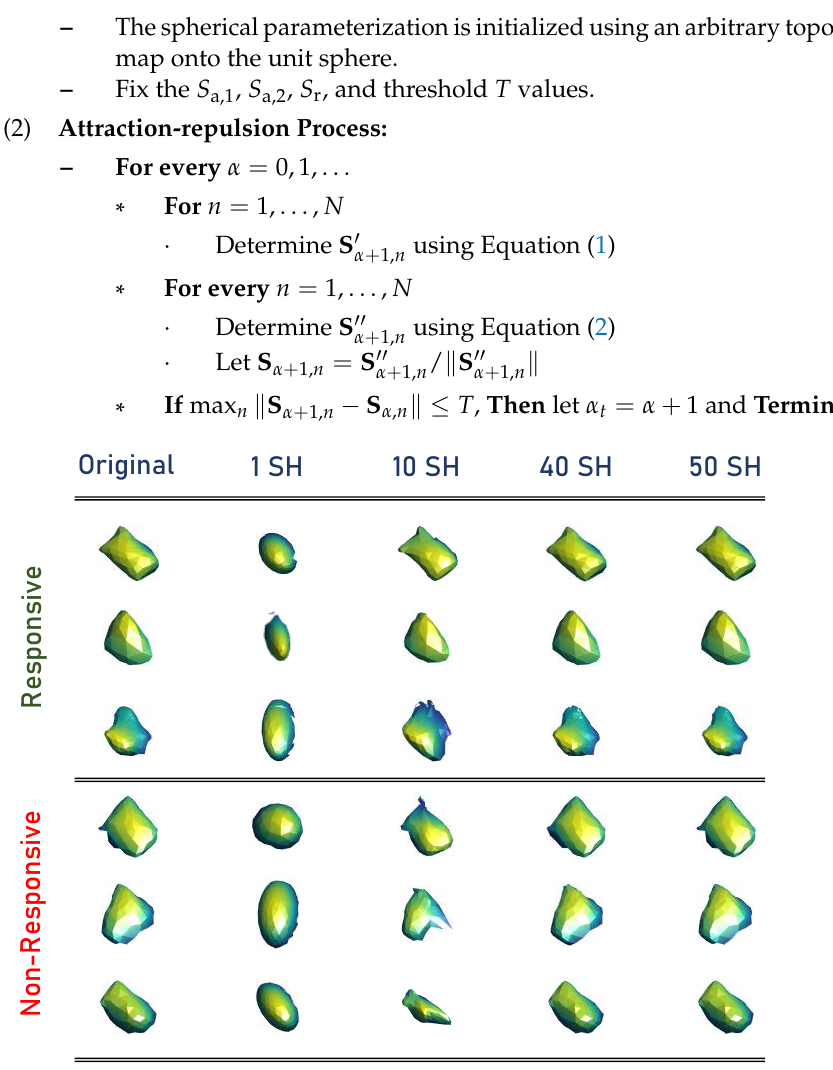
The ROI shape’s elongation reveals the link between the two biggest major compo- nents. It is calculated using Equation (6), where λ 1 and λ 2 refer to the second-largest and the largest axes, respectively. The values fall into a range of 0 to 1, with a 0-value indicat- ing that the object is maximally elongated and a 1-value indicating that the cross-section between the first and second biggest primary moments is